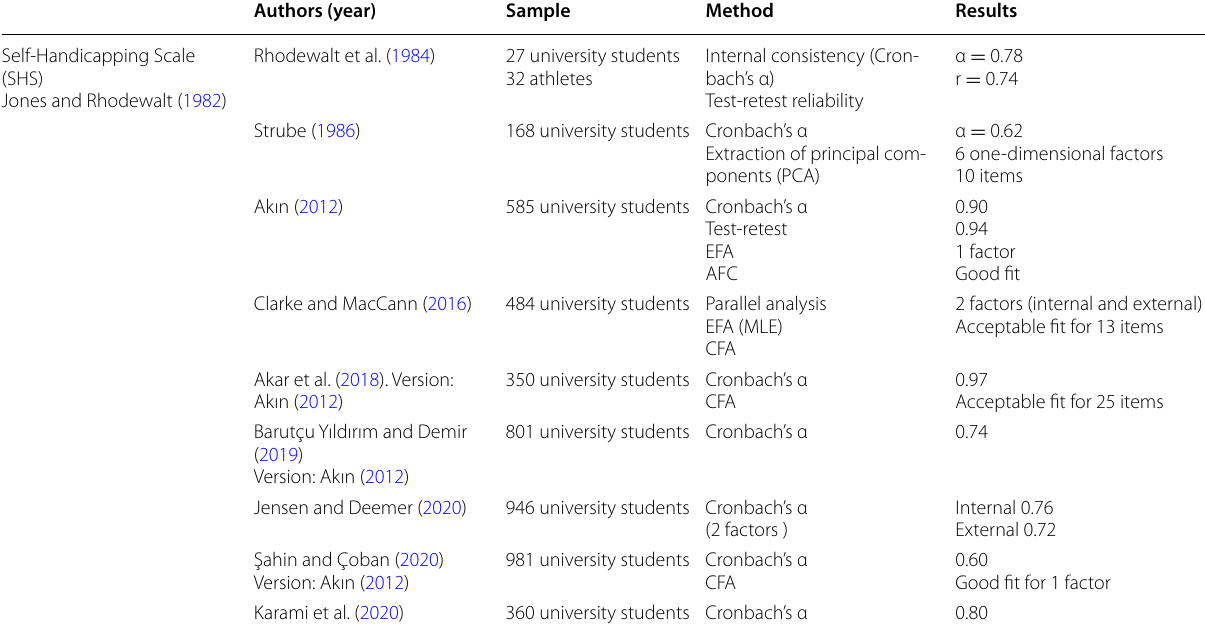
Table 1 Studies with evidence of self-handicapping scale